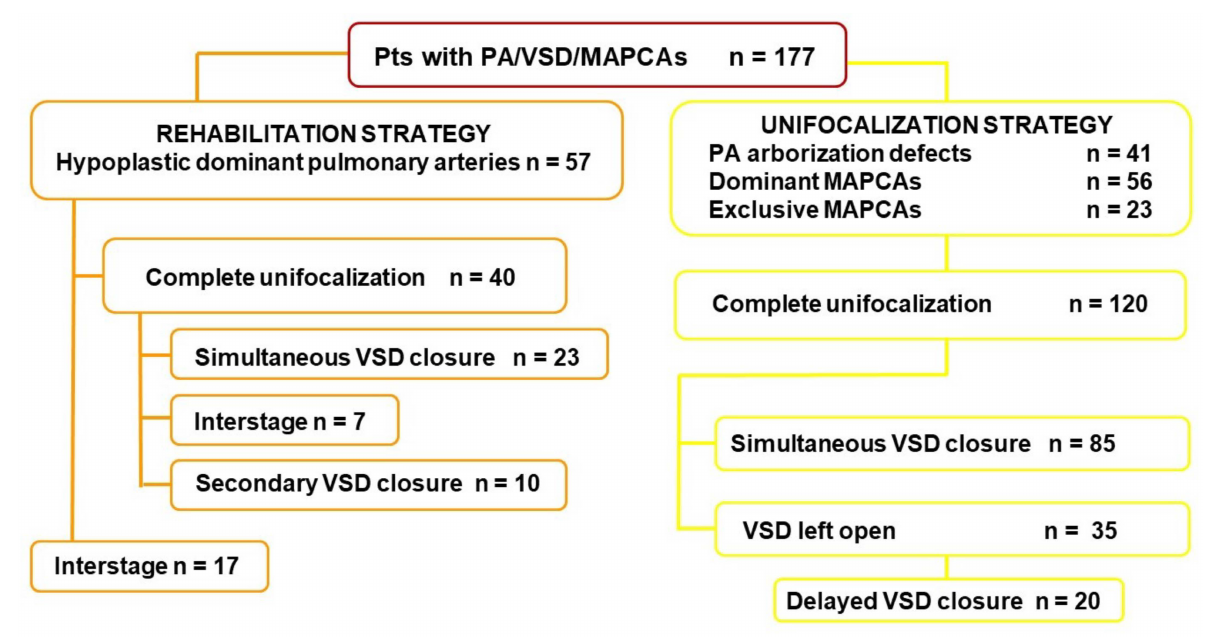
Figure 2. Surgical results of PA/VSD/MAPCAs patients treated at Bambino Ges ù Children Hospital.